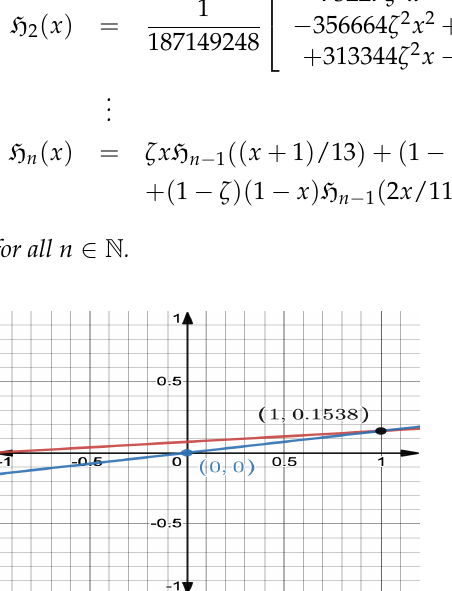
( x ) = x + 1 (red) and G γ 13 1